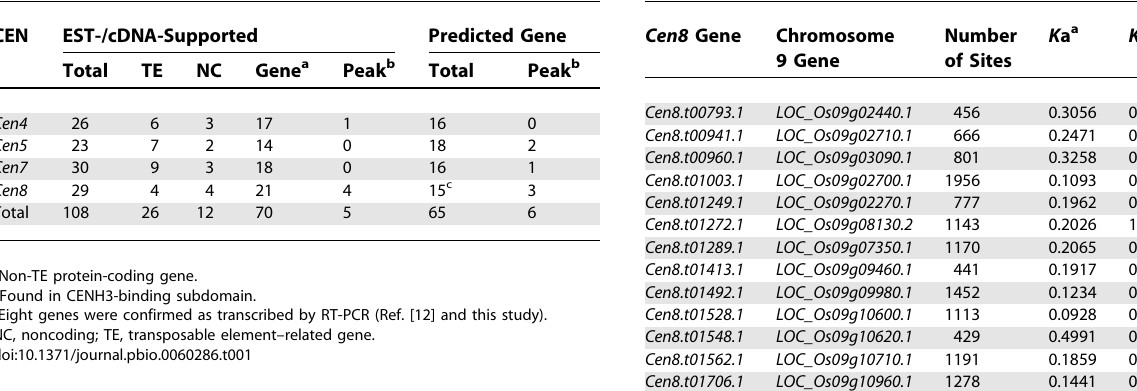
Table 1. Genes and Noncoding Regions Identified from Four 1- Table 2. Estimation of Substitution Rates and Ages for 14